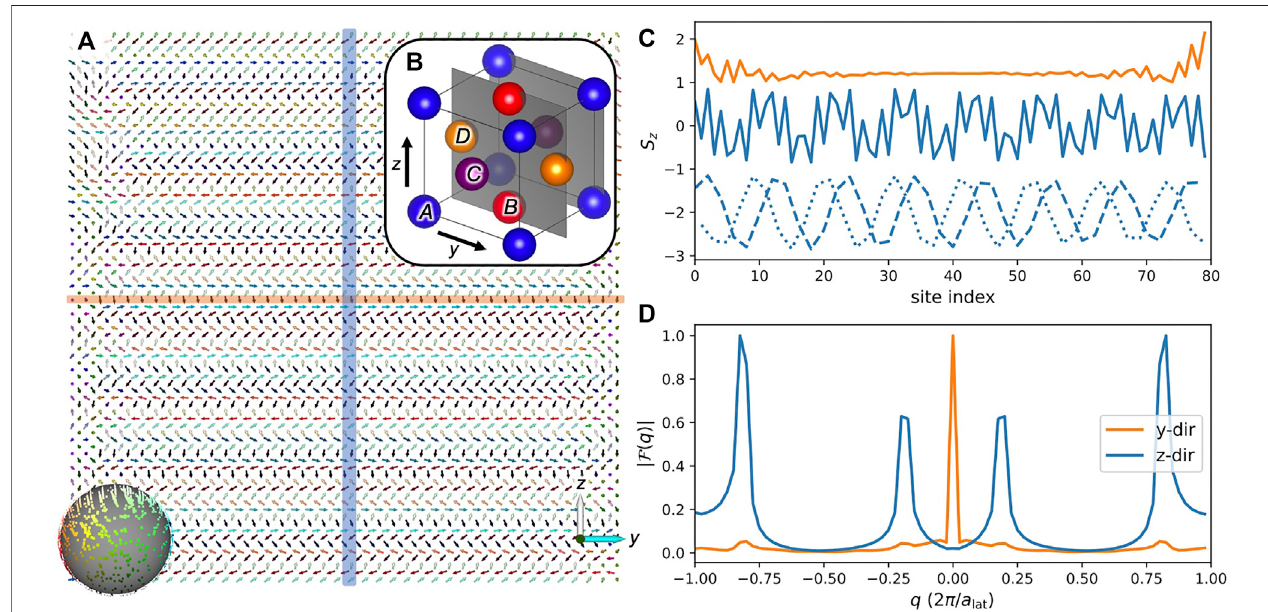
FIGURE 6 | Spin-spiral ground state for γ – Fe at a lattice constant of a lat (cid:1) 3 . 61 (cid:2) A. (A) Cut through the central yz -plane of the 40 × 40 × 40 supercell. Each unit cell consistsof4Featomsonthesub-lattices A , B , C and D shownintheinset (B) .Thecoloredpointsonthegreysphereinthelowerleftofpanel (A) showaprojectionofthe direction of the spins onto the unit sphere. (C) z -component of the spin along the y - (orange line) and z -directions (solid blue line) indicated in (A) with the corresponding colored stripes. Each direction combines the spins from two adjacent yz -planes to cover more than a single sub-lattice per direction (i.e. sites in y -direction consist ofatoms A - B - A - ... ).Thedashedanddottedlinesin (C) areadecompositionof S z ( z )intothesub-lattices A and D .Notethattheorangeanddashedanddottedbluelines are shifted by ± 2 with respect to the solid blue line. (D) Magnitude of the Fourier transformation of S z along the y - and z -directions, i.e. solid orange and blue lines in (C) ,